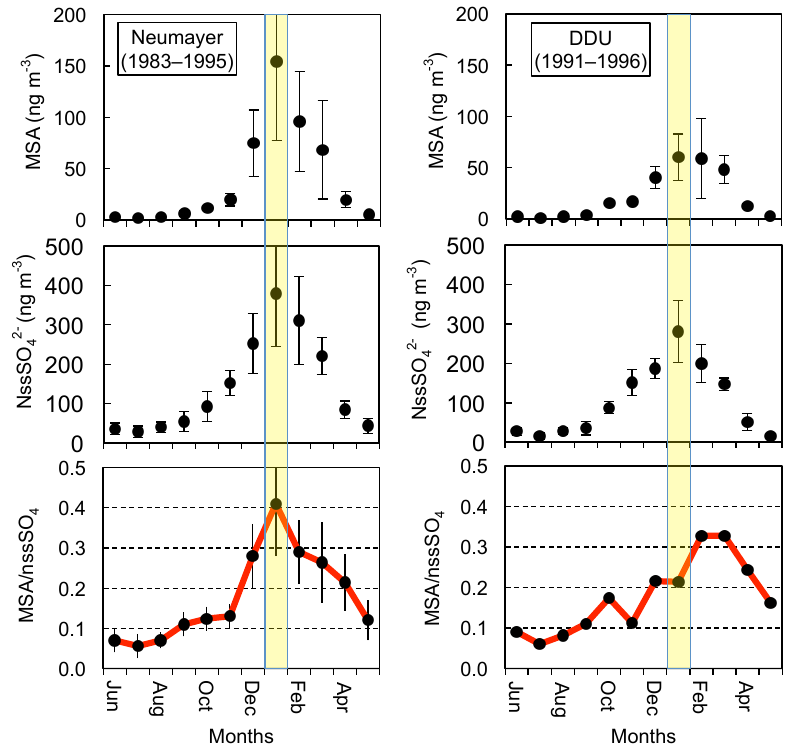
Figure 3. Monthly mean values of MSA, nssSO 4 , and MSA / nssSO 4 ratio, in bulk aerosol collected at Neumayer (1983–1995) (left) and DDU (1991–1996) (right). Adapted from Minikin et al. (1998) and Legrand and Pasteur (1998). Vertical bars denote year-to-year variability. Table 2. MSA / nssSO 4 ratios (R MSA ) observed at inland Antarctic sites in mid-summer and in February/March (if available). Site R MSA